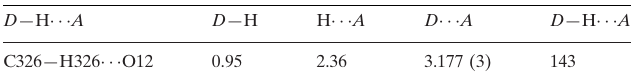
Hydrogen-bond geometry (A˚ , (cid:2) ).